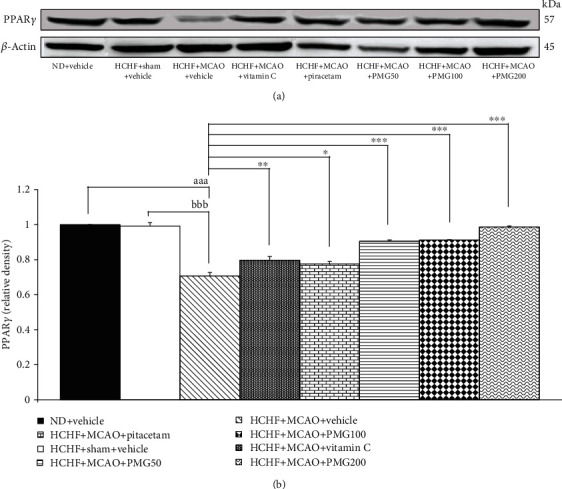
Effect of various doses of PMG on the expression of PPARγ in the cerebral cortex was detected by Western blotting. (a) Representative western blot showing the levels of PPARγ. (b) Relative density of PPARγ. Data are presented as mean ± SEM (n = 6/group). aaap values < 0.001; compared between naïve control rats which received normal diet and vehicle, and metabolic syndrome+MCAO rats which received HCHF, MCAO, and vehicle, bbbp values < 0.001; compared between sham rats which received HCHF, sham operation, and vehicle, and metabolic syndrome+MCAO rats which received HCHF, MCAO, and vehicle and ∗, ∗∗, ∗∗∗p values < 0.05, 0.01, and 0.001, respectively; compared to metabolic syndrome+MCAO rats which received HCHF, MCAO, and vehicle. ND: normal diet; HCHF: high-carbohydrate high-fat diet; MCAO: middle cerebral artery occlusion; vitamin C: the vitamin C at a dose of 250 mg.kg−1 BW; piracetam: the piracetam at a dose of 250 mg.kg−1 BW; PMG 50, PMG 100, and PMG 200: the phytosome containing the combined extract of mulberry fruit and ginger at doses of 50, 100, and 200 mg.kg−1 BW, respectively.